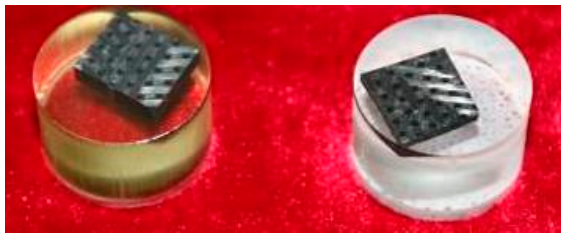
Figure 2. Test samples after curing